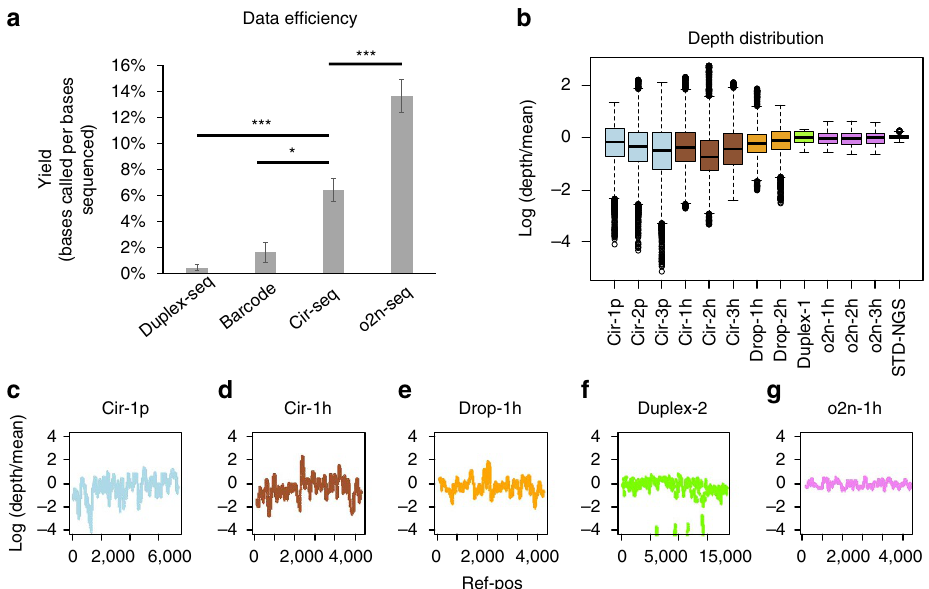
Figure 2 | Data efficiency and read-depth distribution for various ultrasensitive NGS methods. ( a ) Data efficiency of Duplex-seq, barcode method (Safe- SeqS), Cir-seq and o2n-seq libraries (means ± s.d.). Two-tailed Student’s t -test was used for statistical analysis. ( b ) Boxplot of the read depth distribution. The y axis represents the log(e) ratio of the depth over the mean for the genome. Three replicates of Cir-seq for poliovirus (Cir-1p, Cir-2p and Cir-3p) (light blue), three replicates of Cir-seq for phix174 (Cir-1h, Cir-2h and Cir-3h) (brown), two replicates of Droplet-CirSeq (Drop-1h and Drop-2h) (orange), one replicate of Duplex-seq (Duplex-1) (green) and three replicates of o2n-seq (o2n-1h, o2n-2h and o2n-3h) (pink) are plotted. O2n-seq libraries display a more concentrated read depth distribution than the Cir-seq and Droplet-CirSeq libraries and a distribution comparable to Duplex-seq. The depth for each site obtained using o2n-seq is closer to the mean depth value. ( c – g ) Read depth distribution for Cir-seq, Droplet-CirSeq, Duplex-seq and o2n-seq. One example of each type of library is shown here; other cases are shown in Supplementary Fig. 2c. The first and last 100bp of the genomes are excluded. The Duplex-seq data are from ref. 26, the barcode data are from ref. 11, the Cir-seq data for poliovirus are from ref. 25 and the Cir-seq data for phix174 , Droplet- CirSeq and STD (standard-NGS, insert size: 90bp) are from ref. 28.